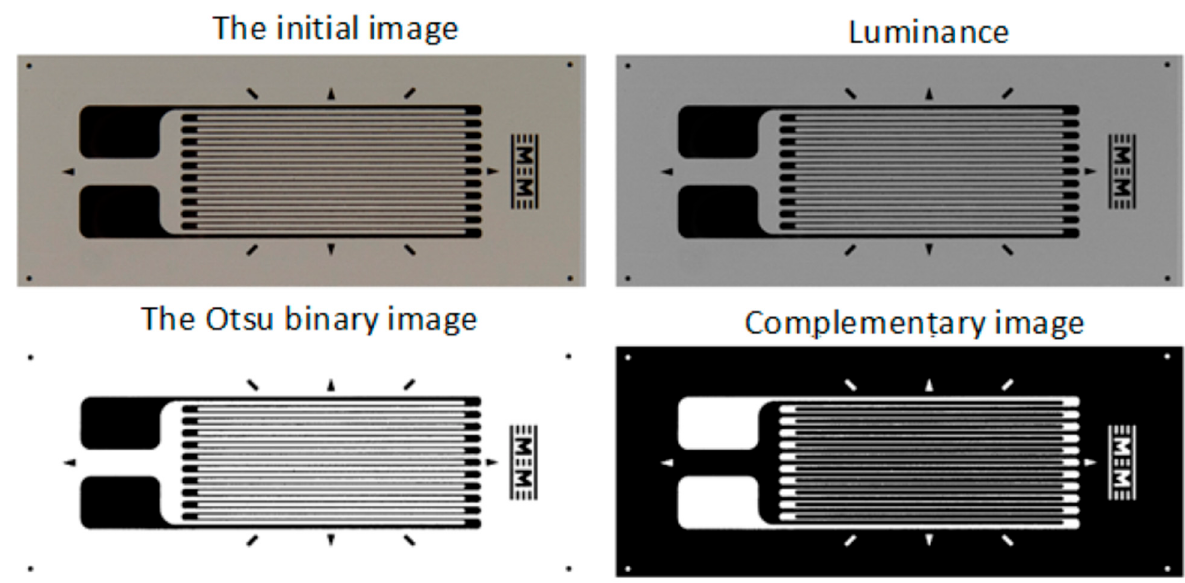
Figure 9. Obtaining the binary image for the type 2 transducer (step 3).